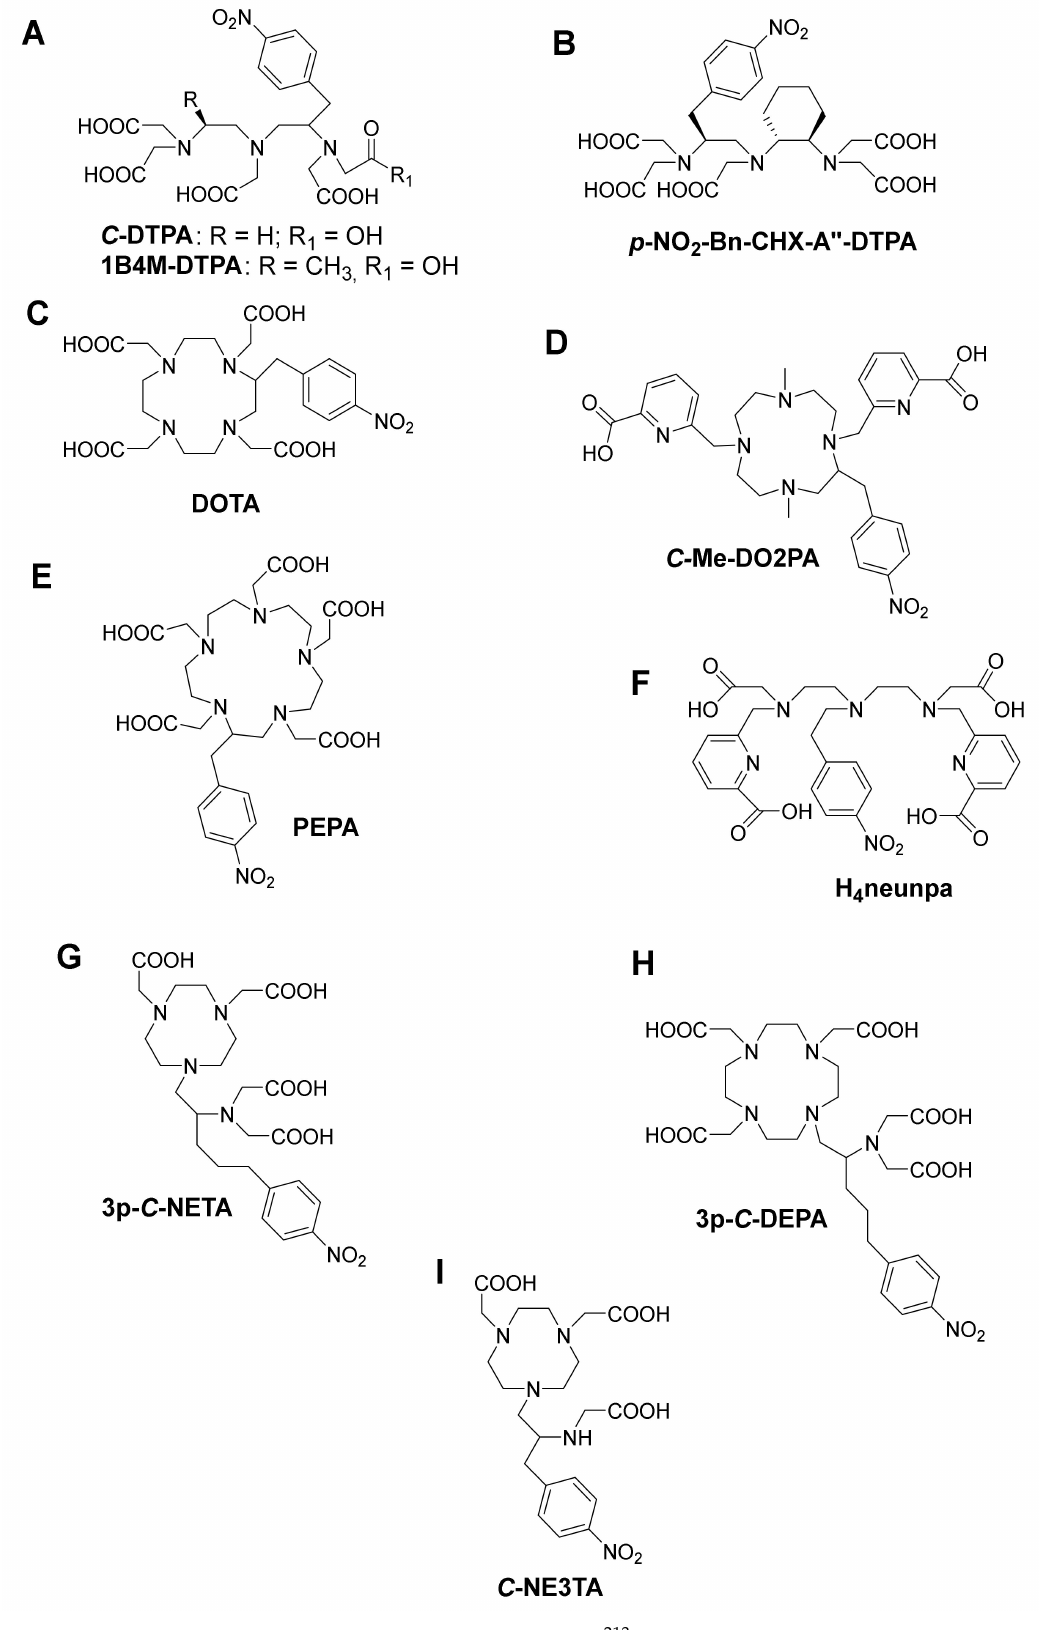
Figure 4. Some structures of bifunctional chelators currently used for 213 Bi ( A ) DTPA and 1B4M-DTPA ( B ) CHX-A”-DTPA, ( C ) DOTA, ( D ) Me-DO2PA, ( E ) PEPA, ( F ) H4neunpa, ( G ) 3p- C -NETA ( H ) 3p- C -DEPA and ( I ) C